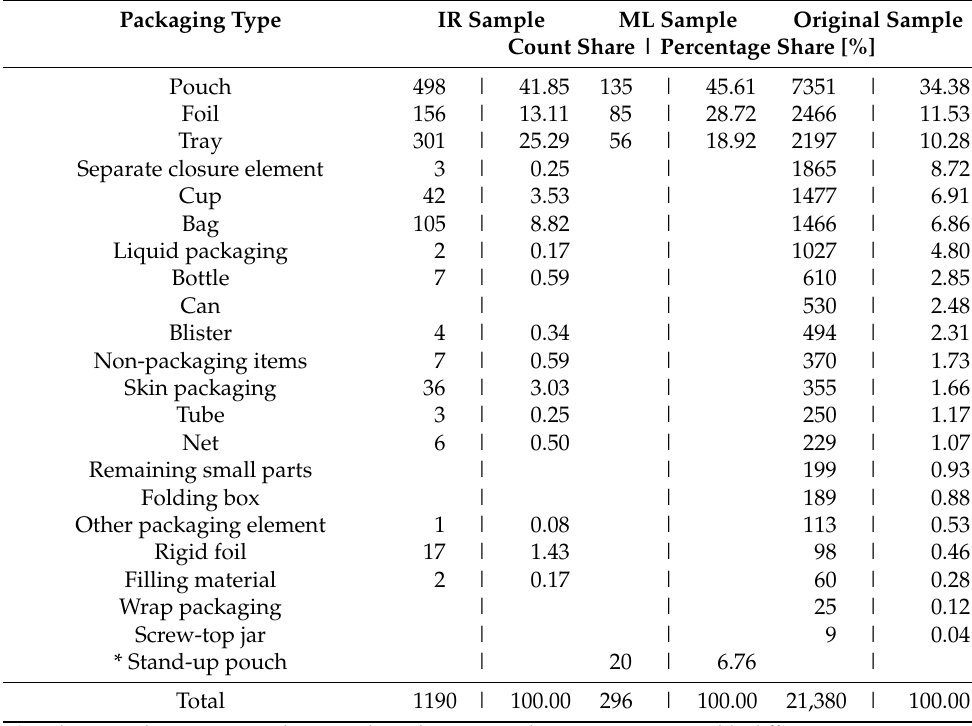
Table 5. Examined packaging of the IR sample, the ML sample, and the original